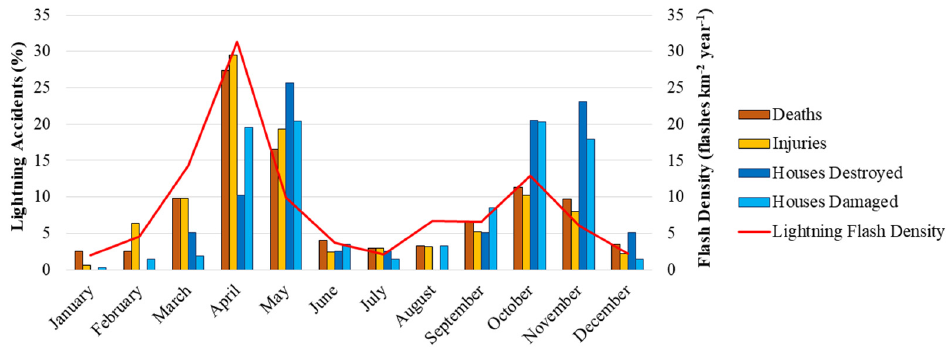
Figure 4. Monthly variation of lightning accidents in Sri Lanka from 1974 to 2019.